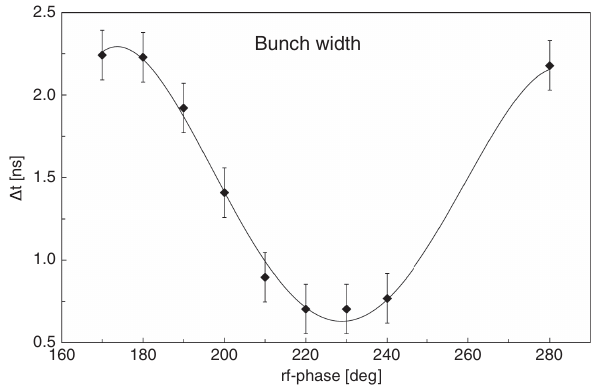
FIG. 12. Measured width of the bunch length (rf phase scan) for Ar 9 þ beam at an accelerating gradient of 3 . 5 MV/m.